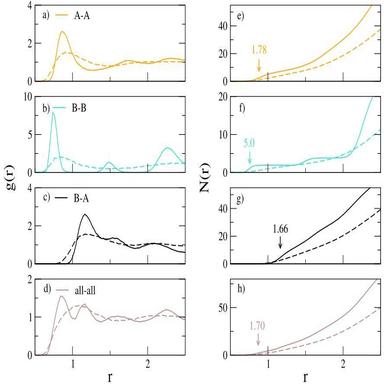
(a-d) Radial distribution function for the different particle pairs in the system forming the hexagonal phase ( = 0.24). (e-h) Coordination number for the different species, with the values of order(1)∕desorder(1) indicated at the first-neighbor distances for each type of particle pair. The isotropic phase is represented by dashed lines and the ordered mesophase is represented by solid lines.